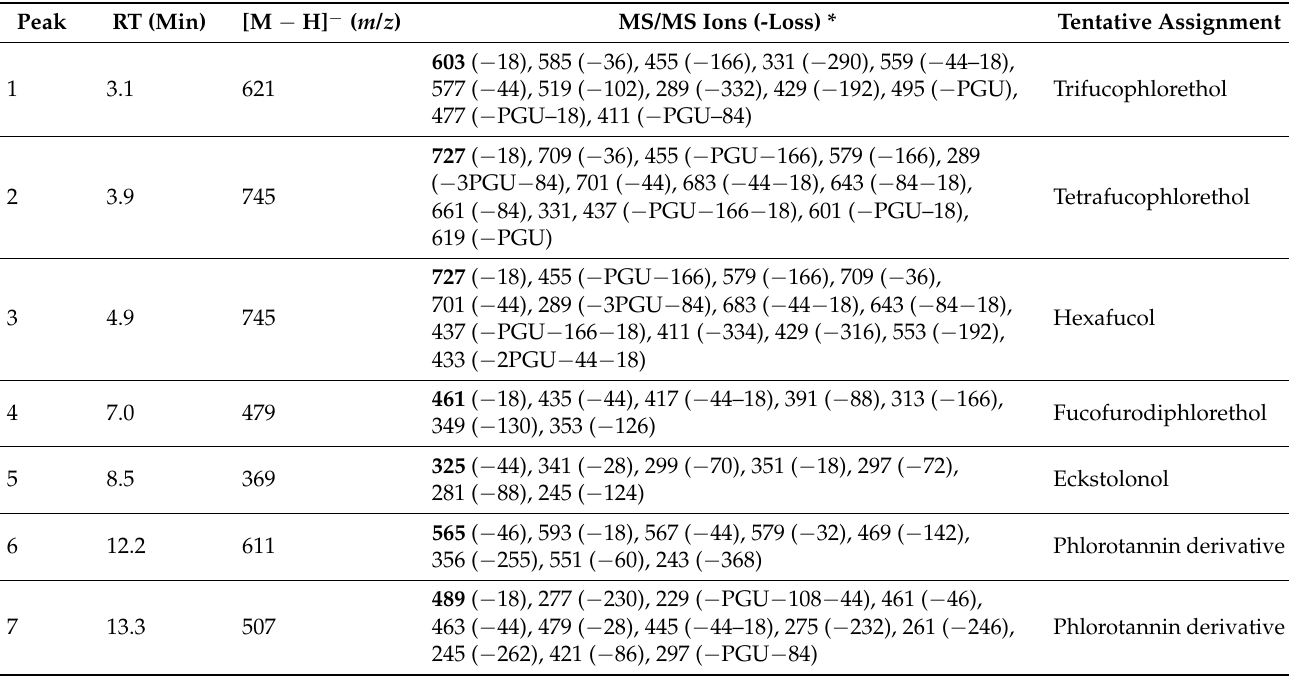
Table 1. Tentative assignment of the compounds detected in the F5 analyzed by UHPLC-ESI-MS/MS.